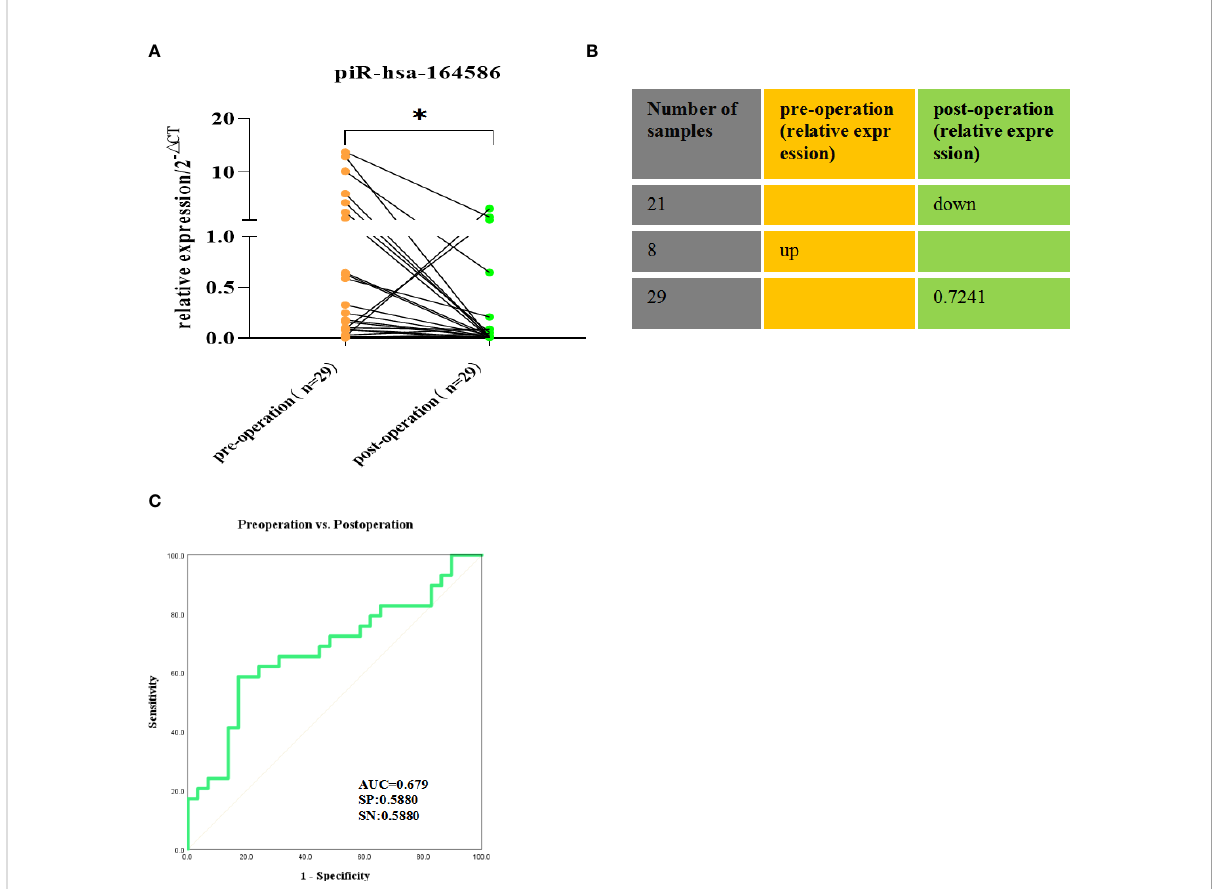
FIGURE 5 Comparison of the expression of piR-hsa-164586 of extracellular vesicles in preoperative and postoperative serum samples of NSCLC patients.(ns, no signi fi cance; *p < 0.05). (A) The relative expression of piR-hsa-164586 of extracellular vesicles before and after operation; (B) The percentage of decreased expression of piR-hsa-164586 in postoperative samples is 72.41% (C) ROC curve analysis of postoperative prognostic performance of NSCLC patients(SN, sensitivity; SP, speci fi